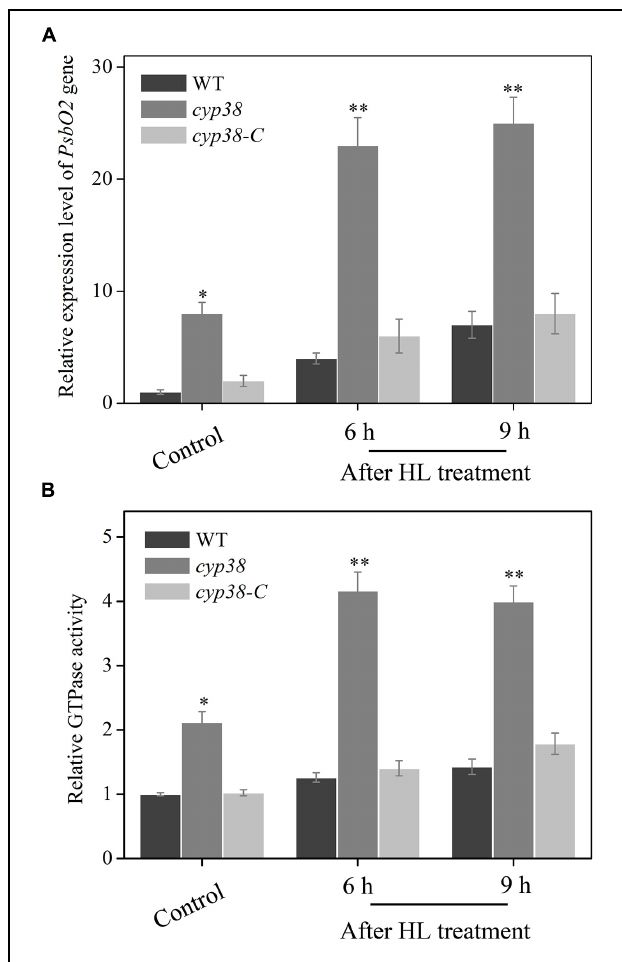
FIGURE 6 | Effect of CYP38 on HL-induced PsbO2 gene expression and its GTPase activation in Arabidopsis . (A) qRT-PCR analysis of PsbO2 gene expression in plants of WT, cyp38 and cyp38-C with or without HL treatment. (B) GTPase activity analysis using PSII membranes extracted from WT, cyp38 and cyp38-C , then treated with or without HL for subsequent test. WT GTPase activity at control light was set to 1. Error bars are ± SD values for three replicates. Asterisks ( ∗ ) indicate a significant difference from the control at ∗ P < 0.05, ∗∗ P <